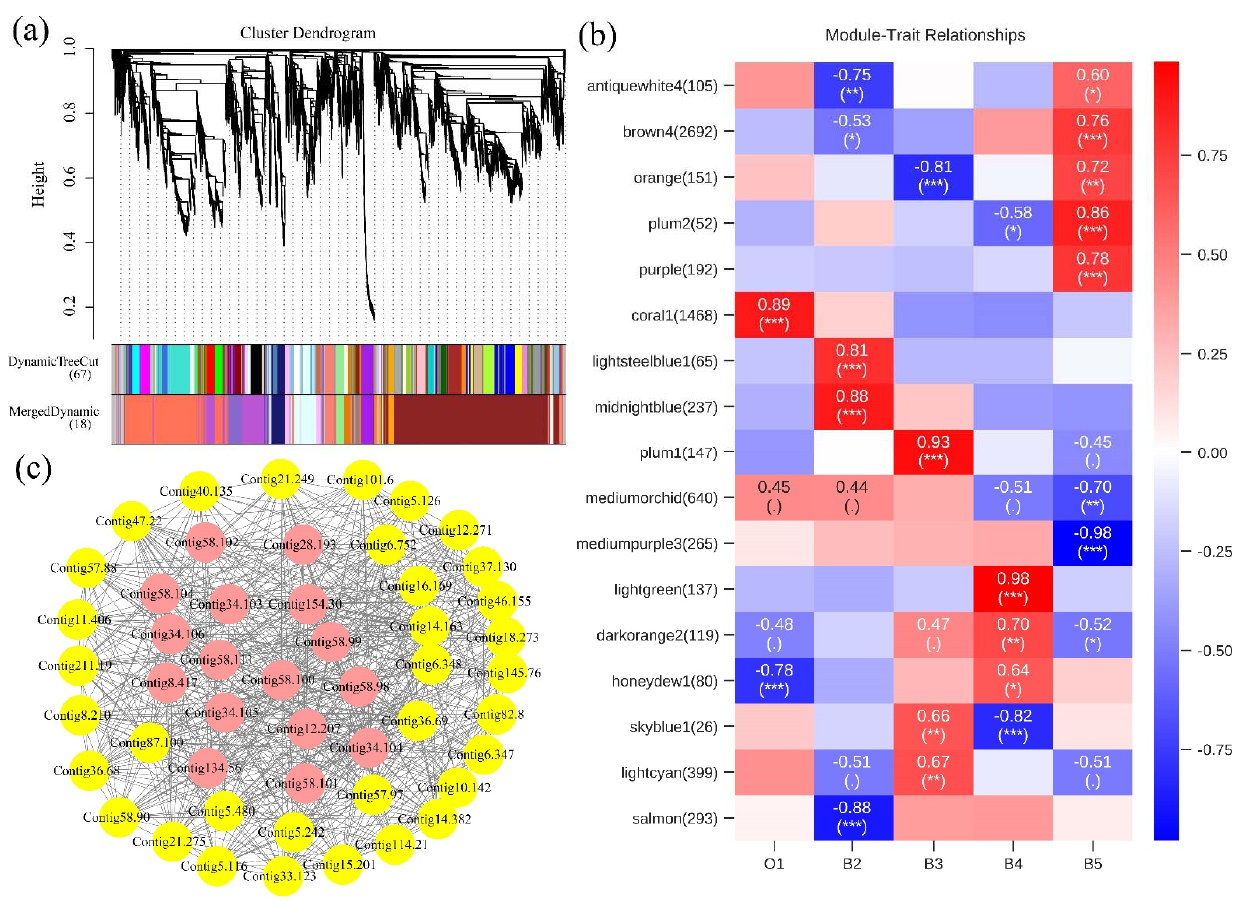
Figure 7. Hierarchical clustering dendrogram for modules identified by WGCNA. ( a ) Functional modules were shown with different colors. In total, 7206 genes were divided into 18 modules, which were assigned different colors. ( b ) Module-trait relationships. Each row corresponds to a module. Each column corresponds to a different developmental stage. The number of each cell at the row–column intersection indicates the correlation coefficient between the module and developmental stages; “.” indicates a p value greater than 0.1, “*” indicates a p value less than 0.1, “**” indicates a p value less than 0.01, “***” indicates a p value less than 0.001. The color bar on the right shows the correlation coefficient between traits and modular characteristic genes from red (high) to blue (low). ( c ) Weighted co-expression network for genes in the plum1 module. Yellow circles show top 50 hub genes in this module. Pink circles represent genes encoding cuticular proteins ( CPs ). Lines represent the weight of connectivity between